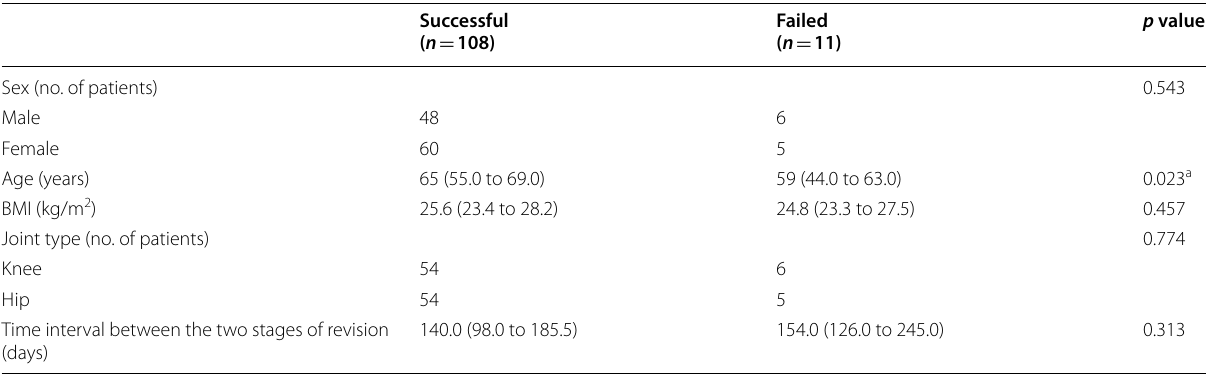
Time interval between the two stages of revision Median values are shown with interquartile ranges in parentheses BMI body mass index a means the data has statistical difference